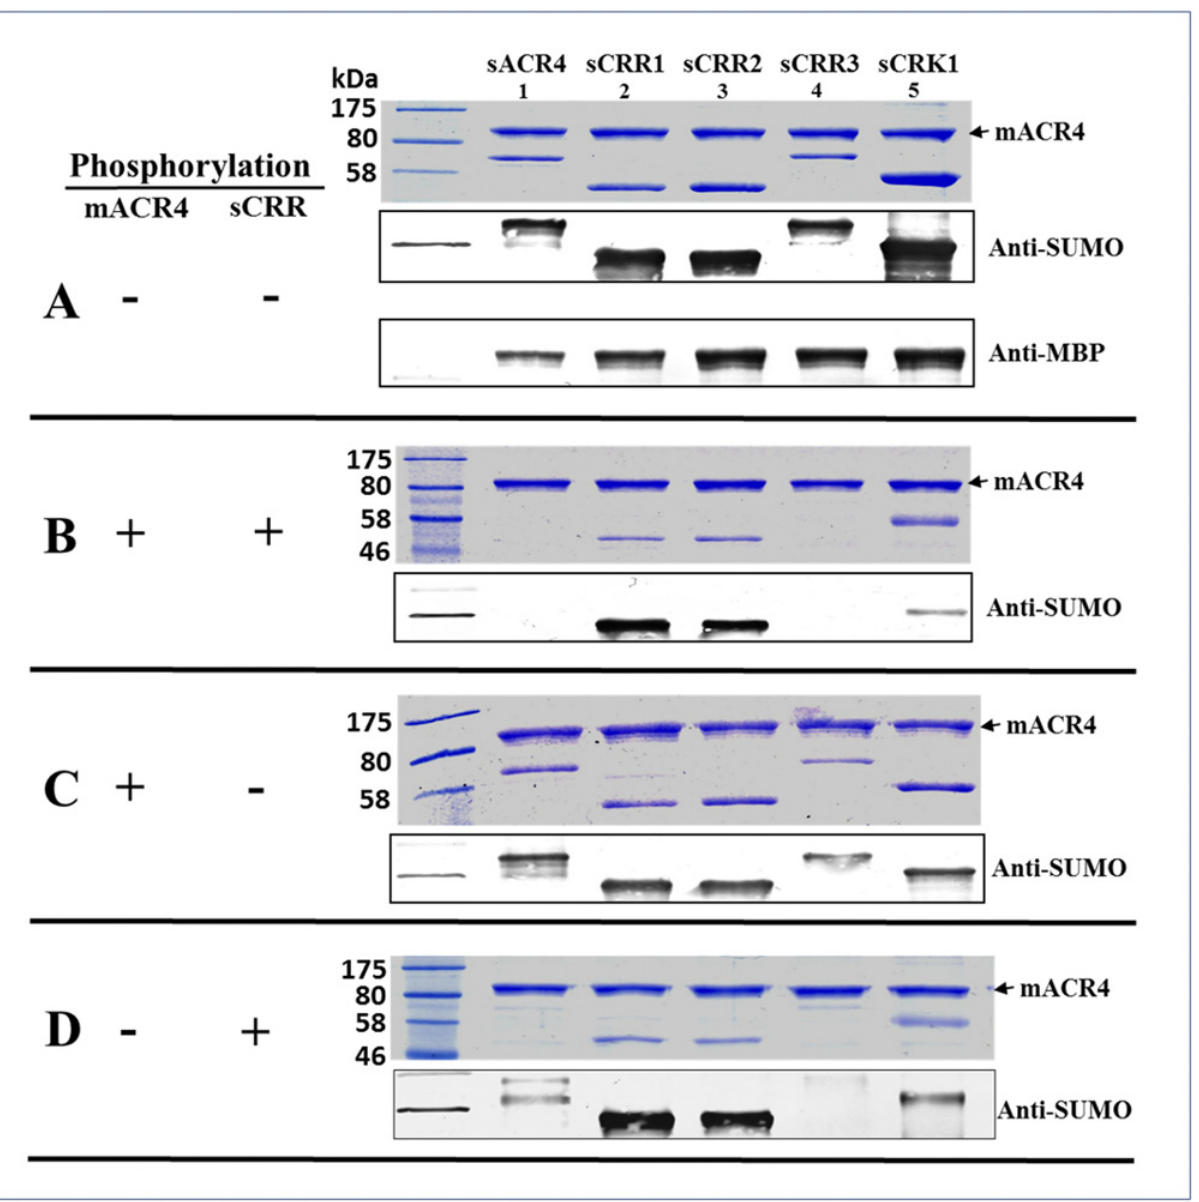
Fig 2. Effect of autophosphorylation on ICD interactions. Pull-down assays were performed to determine the effects of phosphorylation on interactions between the ICDs of ACR4 and the CRRs. The autophosphorylation status of each protein was varied for individual experiments, (+) denotes autophosphorylated protein, (-) denotes unphosphorylated protein. In (A), mACR4 (-) and sCRRs (-), (B) mACR4 (+) and sCRRs (+), (C) mACR4 (+) and sCRRs (-), (D) mACR4 (-) and sCRRs (+). In A-D, proteins were separated by 12% SDS-PAGE ( top panels ) and the presence of interacting proteins was determined by anti-SUMO western blot ( lower panels ). In the bottom panel of A, anti-MBP western blot demonstrates the presence of mACR4 in each